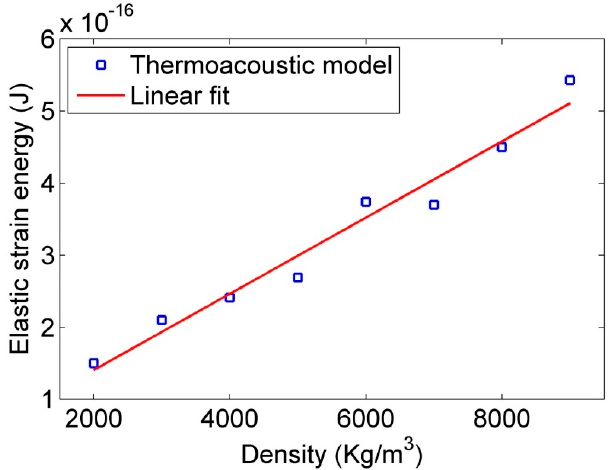
Figure 13. Effect of density on the normal stress at the clamp end of nanowire.